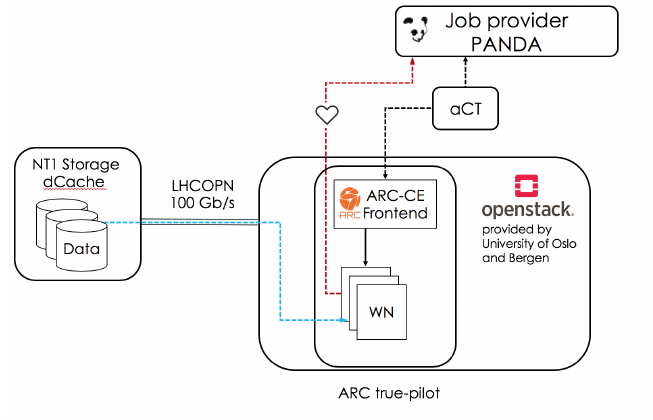
Figure 5: ARC and its interaction with the worker nodes, ARC Control Tower (aCT), PanDA and the Nordic Tier 1 (NT1) storage elements managed by